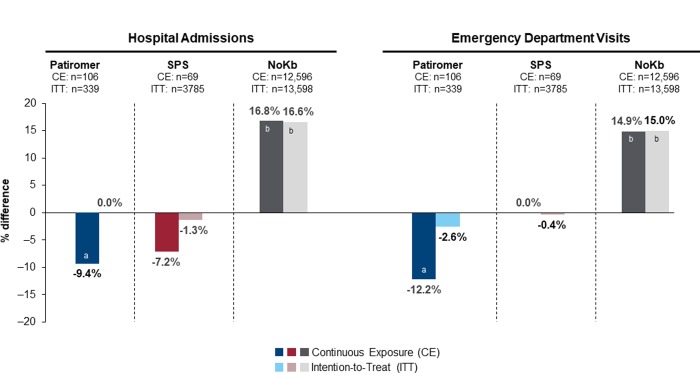
Change in percentage of patients (pre- vs post-index) with at least one hospital admission or ED visit: By treatment group and exposure classification (CE, ITT).Analyzed using McNemar’s test for paired nominal data (% post-index–% pre-index): aP<0.05, bP<0.001. CE, continuous exposure; ITT, intention-to-treat; SPS, sodium polystyrene sulfonate.